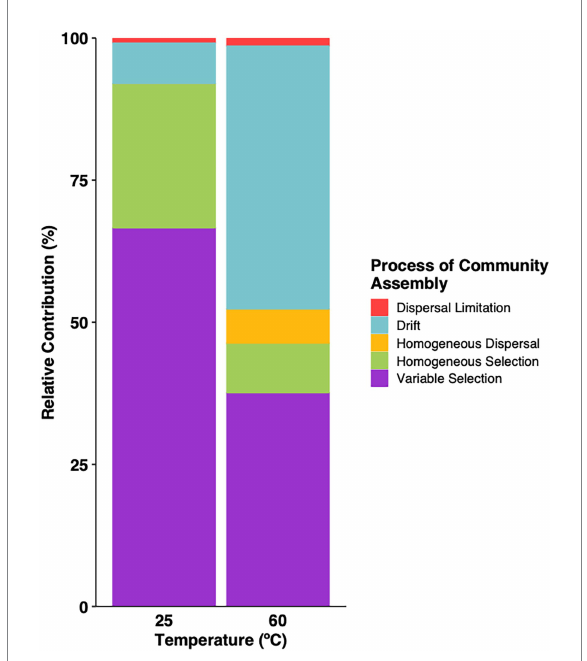
FIGURE 7 Relative contribution of ecological processes to community assembly for samples incubated under thermophilic conditions or at 25 ° C. Values were estimated using β MNTD and β